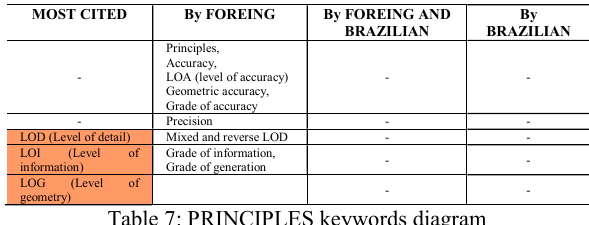
Table 7: PRINCIPLES keywords diagram 4.2 Survey of Brazilian and foreign researchers The intention is to identify a network of researchers. Five countries were identified aggregating the majority of foreign researchers: Italy (100), Canada (51), Belgium (20), Germany (19) and United Kingdom (15) (figure 7). However, there are thirteen countries that haven’t interacted with other countries (figure 1).